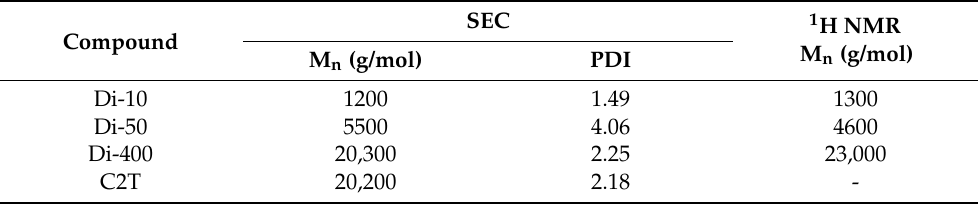
Table A1. Number average molecular weights (M n ) and polydispersity indices (PDI) of Di-10, Di-50, Di-400, and C2T. The data were obtained by SEC and 1 H NMR. The molecular weights obtained by SEC were used for the further calculation of the silicone elastomer network